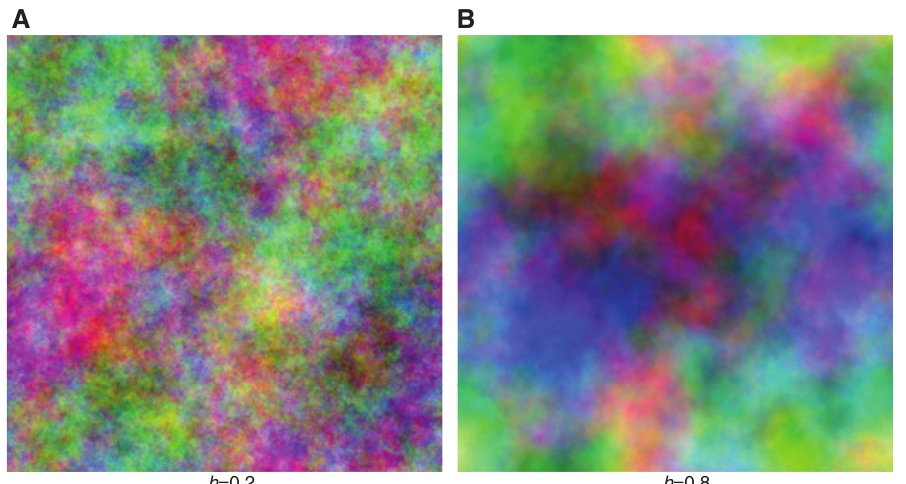
Figure 5: Two color fractional Brownian surfaces.